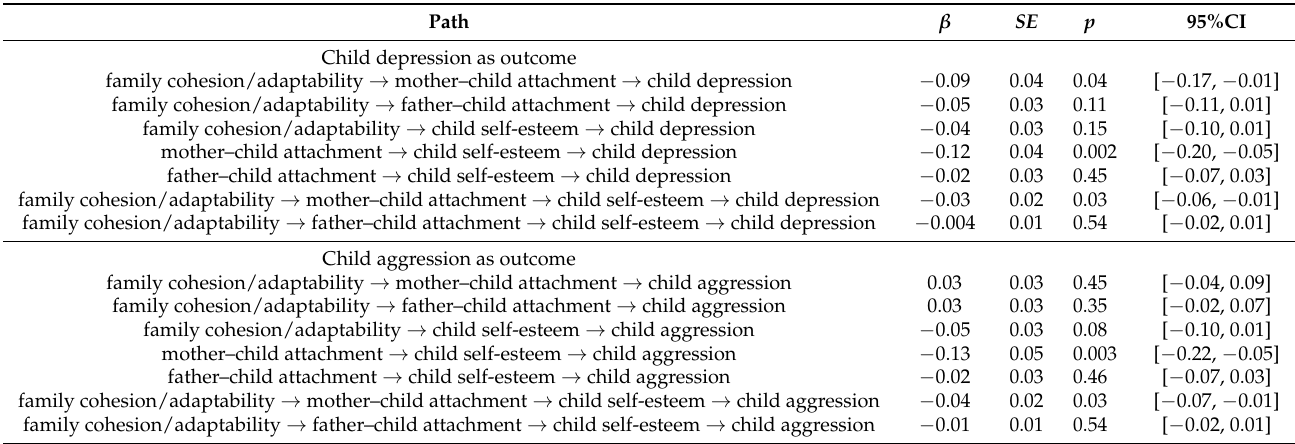
Table 3. Indirect Effects for Mediation